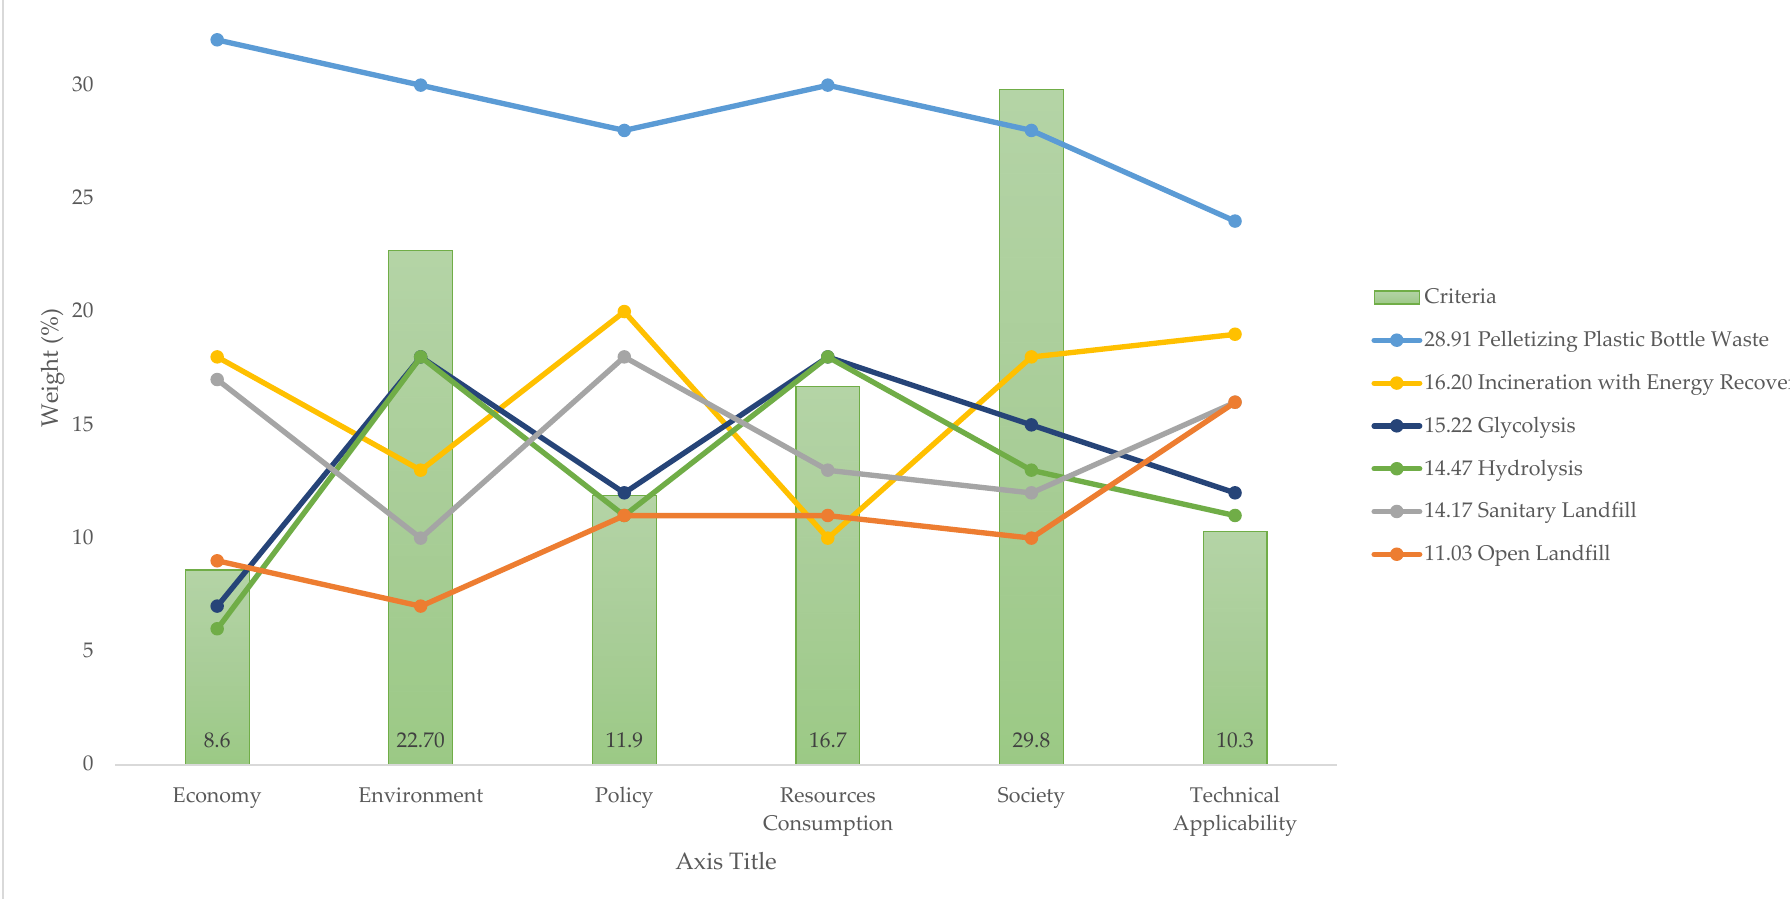
Figure 10. Sensitivity analysis: AHP model from experts’ judgments (%).